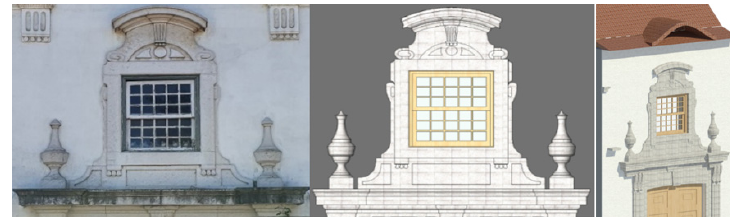
Figure 18. The guillotine window: picture and model.